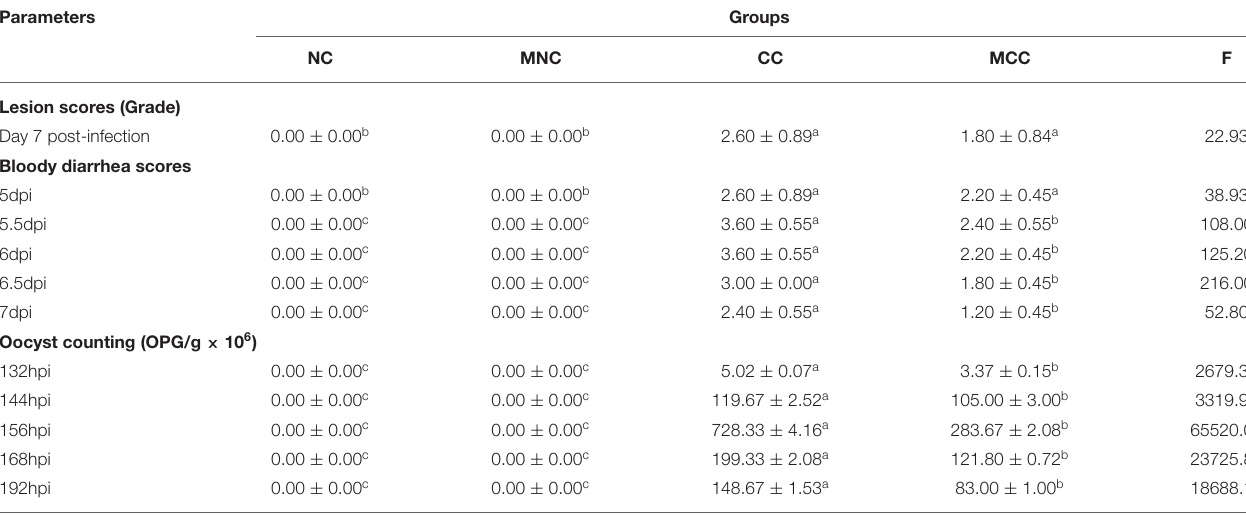
TABLE 1 | Effects of MGQD on bloody diarrhea scores, oocyst shedding, and lesion scores. Parameters Groups NC MNC CC MCC F Lesion scores (Grade) Day 7